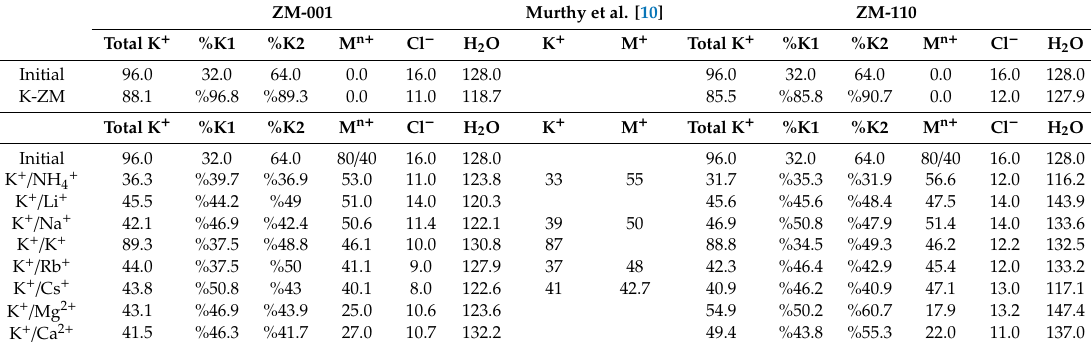
Table 1. Number of initial and retained ions in K-ZM without guest cations, ZM-001 and ZM-110 membranes as well as their comparison with a previous study [10]. The potassium retained in Site I and Site II after 8.5 ns simulations are as